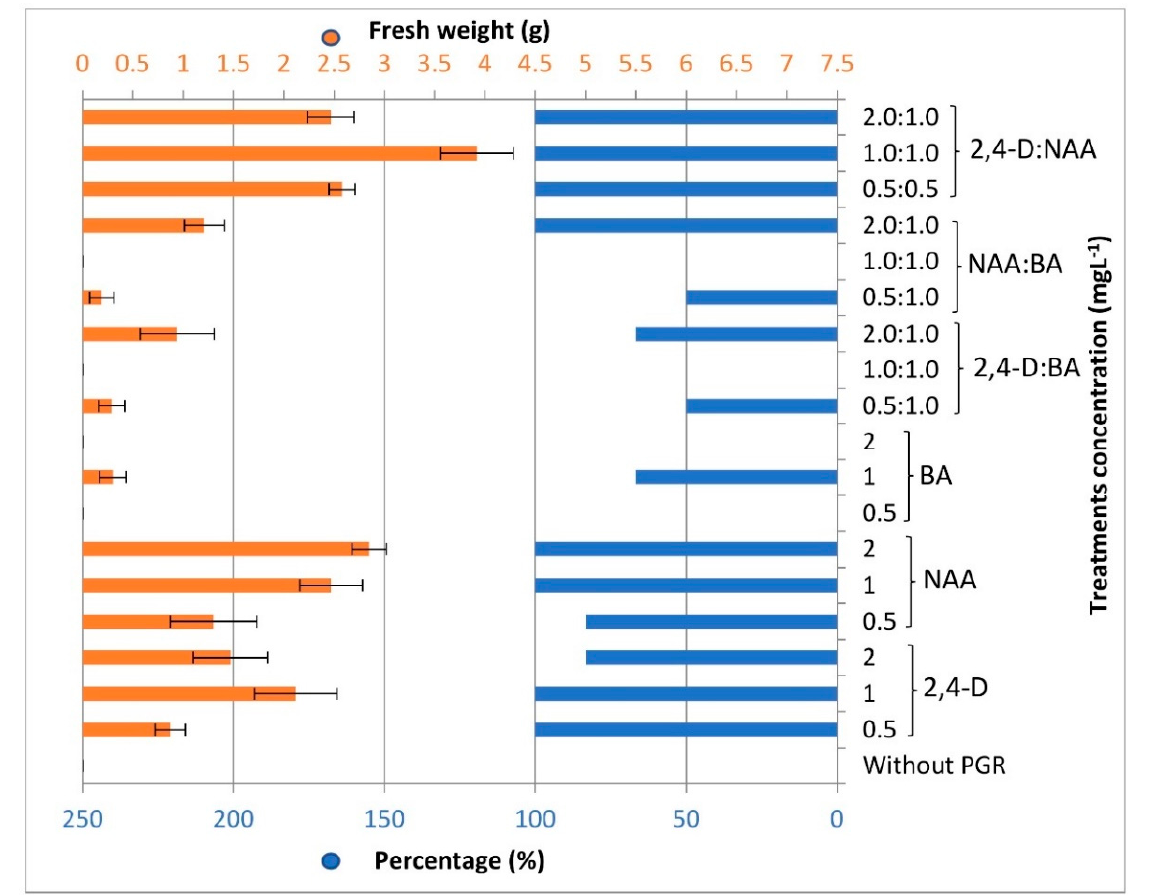
Figure 2. Callus induction percentage and fresh weights of callus induced from L. schweinfurthii leaves.